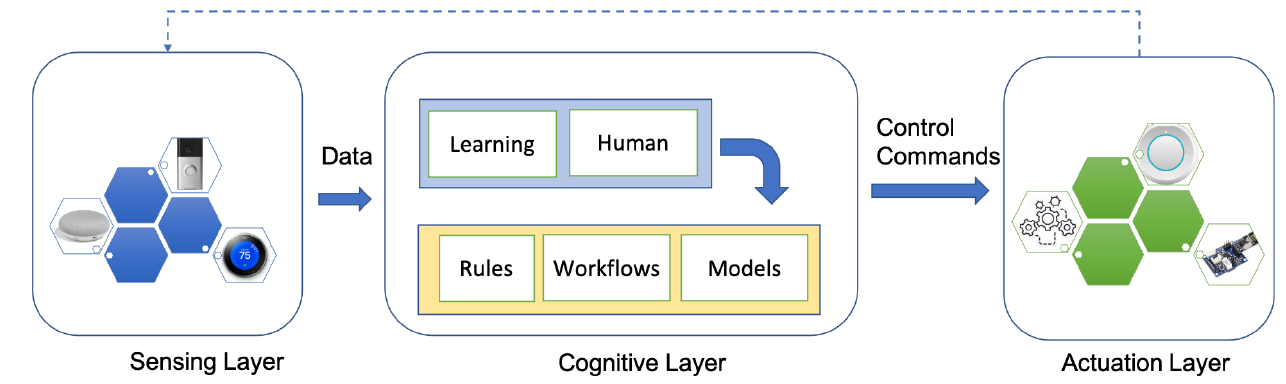
Figure 1. Three-layer model of an Internet of Things (IoT)-based system including sensing, context, and actuation